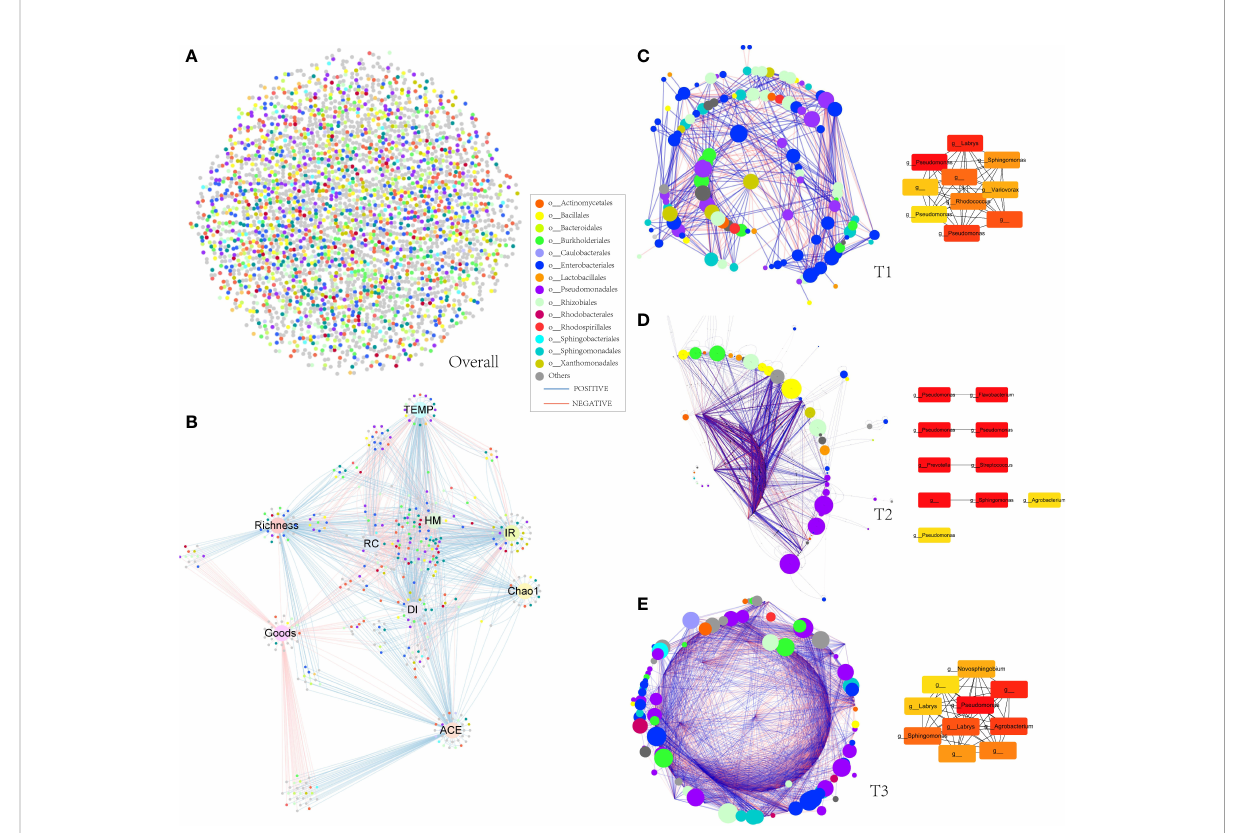
FIGURE 5 Molecular ecological networks of phyllospheric bacterial community. Each node represents an OTU. The size of each node is proportional to the number of connections (that is, degree) and the colors of nodes represent different order. The links between the nodes indicate strong and signi fi cant ( P < 0.01) correlations. A red line indicates a negative interaction between two individual nodes, while a blue line indicates a positive interaction. (A) Overall molecular ecological network; (B) spearman correlation between environmental factor, alpha diversity index, and OTUs. (C) molecular ecological network of T1 group (left) and predicted keystone nodes (right); (D) molecular ecological network of T2 group (left) and predicted keystone nodes (right); (E) molecular ecological network of T3 group (left) and predicted keystone nodes